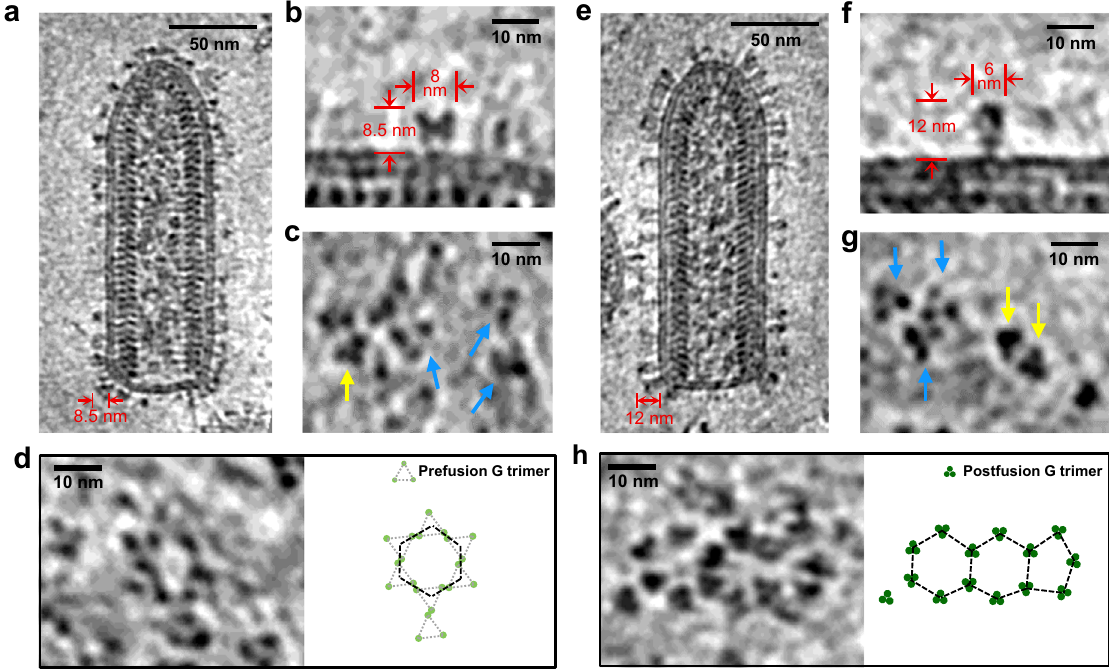
Fig. 4 | In situ structures of VSV G trimers and their hexagonal/pentagonal distribution.a A6Å-thickdensityslicefromareconstructedtomogramshowinga representative VSV virion puri fi ed without a density gradient centrifugation step. The 8.5nm-thickness of glycoproteins indicates that most G are in prefusion con- formations. b , c VSV G trimers in prefusion mostly or postfusion conformation occasionally. b The side view of a representative G trimer in prefusion conforma- tion from 4452 trimers obtained by template matching; c The top views of G tri- mers.Trimersinprefusionconformation,arepointedbybluearrows,whilethosein postfusionconformationbyyellowarrows. d Exampleofahexagonaltileformedby prefusion G trimers on the viral membrane. e A 6Å-thick density slice from a